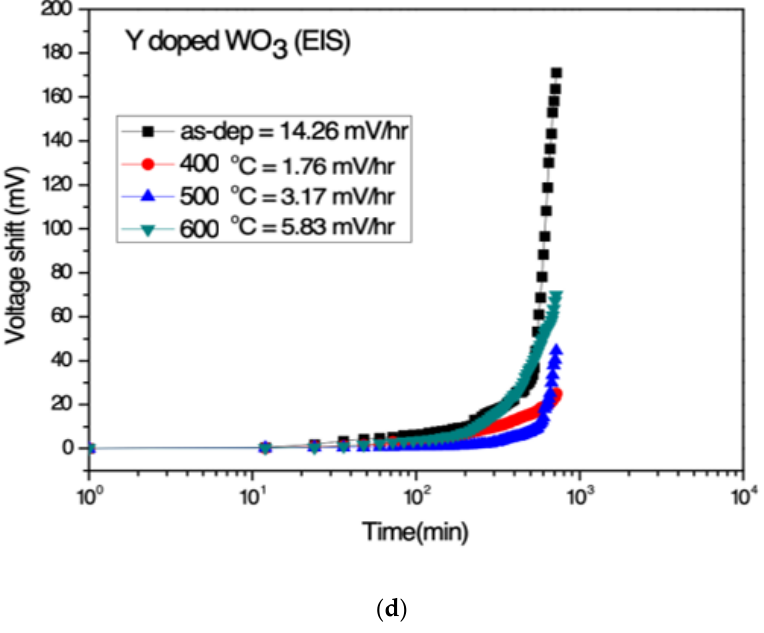
Figure 6. ( a ) Hysteresis voltage of WO 3 sensing membrane based on EIS with various RTA temperatures in O 2 ambient during the pH loop of 7 → 4 → 7 → 10 → 7. ( b ) Hysteresis voltage of Y-doped WO 3 sensing membrane based on EIS with various RTA temperatures in O 2 ambient during the pH loop of 7 → 4 → 7 → 10 → 7. ( c ) Drift voltage of WO 3 sensing membrane based on EIS with various RTA temperatures in O 2 ambient, then dipped in pH 7 buffer solution for 12 h. ( d ) Drift voltage of Y-doped WO 3 sensing membrane based on EIS with various RTA temperatures in O 2 ambient, then dipped in pH 7 buffer solution for 12 h.